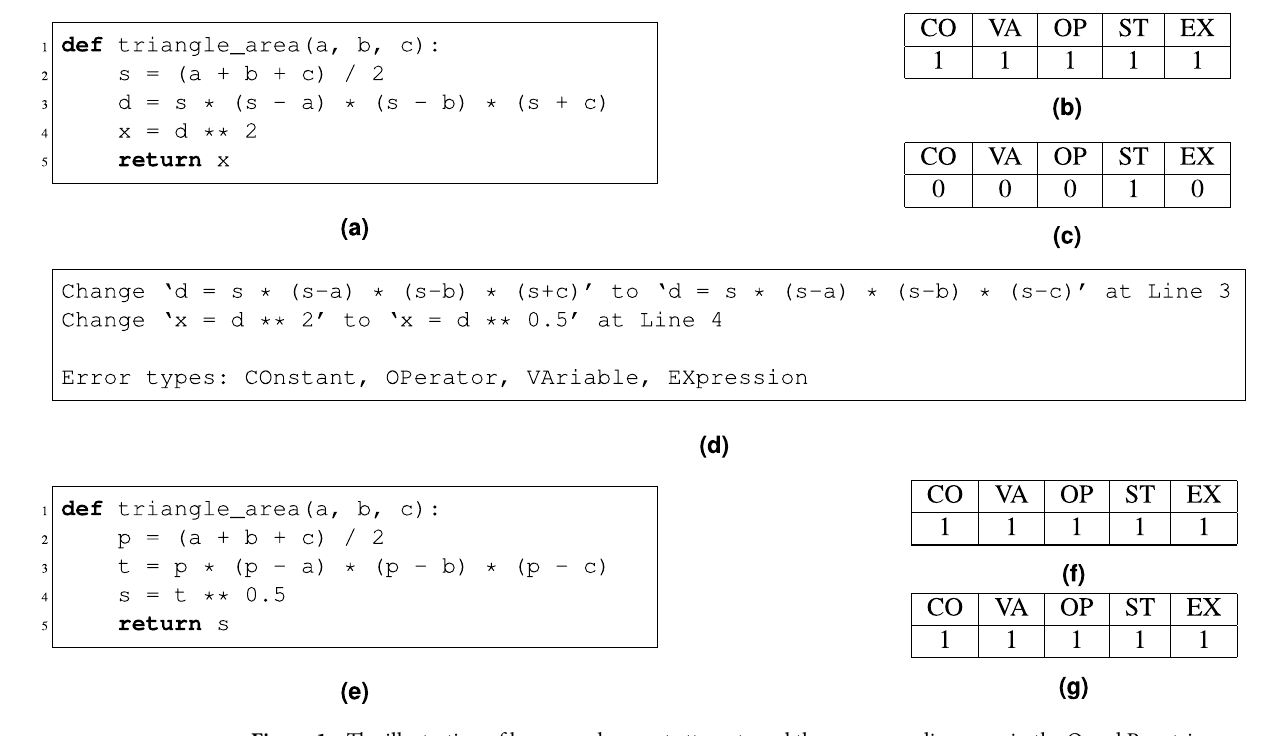
Figure 1. The illustration of buggy and correct attempts and the corresponding rows in the Q and P matrices. ( a ) Buggy attempt B1 . ( b ) Row for B1 in Q-matrix. ( c ) Row for B1 in P-matrix. ( d ) Repair result for B1 . ( e ) Correct attempt C1 . ( f ) Row for C1 in Q-matrix. ( g ) Row for C1 in